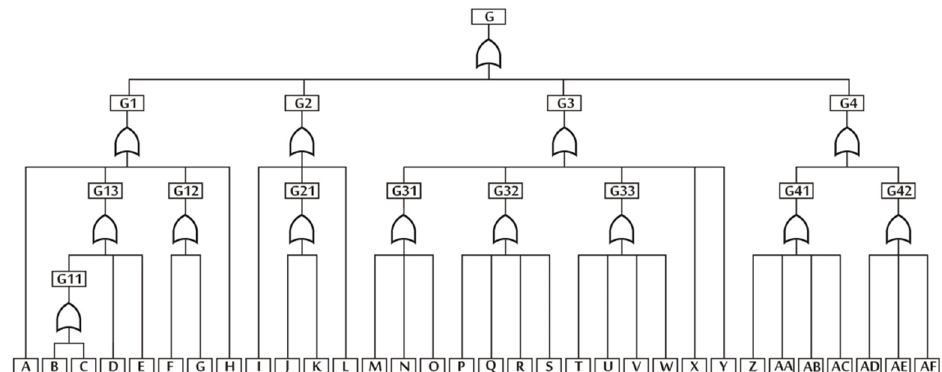
Figure 2. The fault tree.